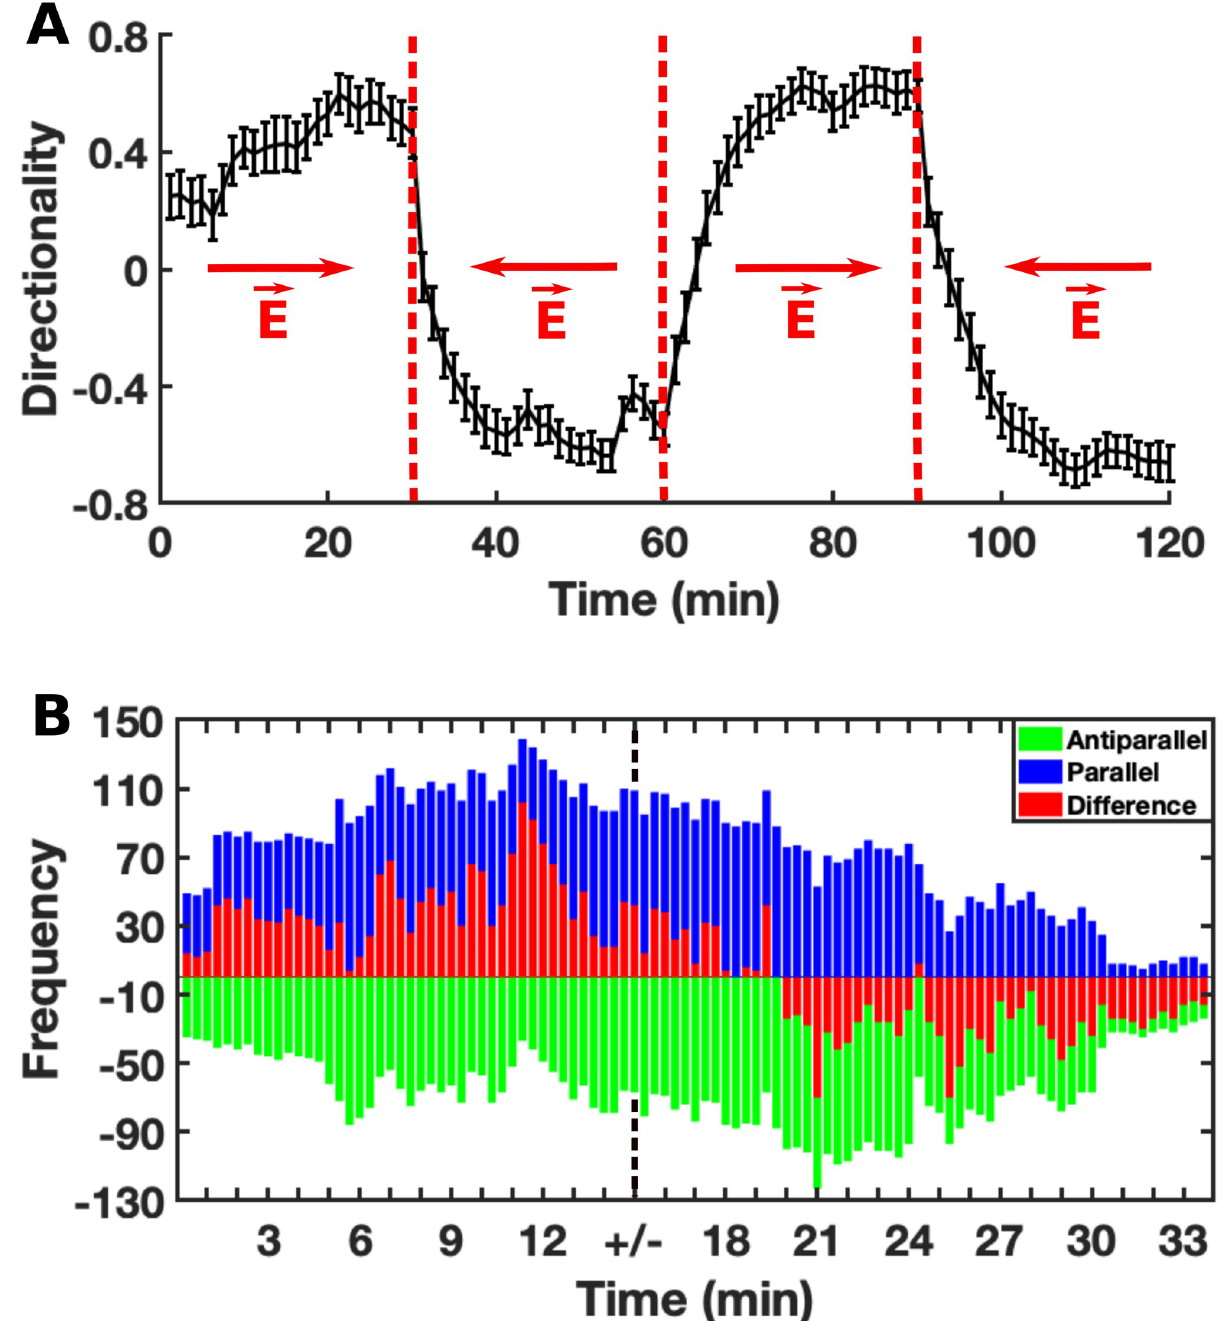
Fig 4. Directionality and F-actin localization upon electric field reversal. A. Directionality of Dd cells in an electric field. The polarity of the field is reversed every 30 minutes as indicated by the red arrows. The graph is obtained from at least three different experiments. The data are displayed as mean ± s . e . m .B. F-actin localization within the cell during cellular migration and its dynamics when the polarity of the electric field changes. At each point in time, the number of cells with F-actin localized towards the cathode (blue), towards the anode (green) and their difference (red) are displayed. The black dotted line indicates the time point of polarity